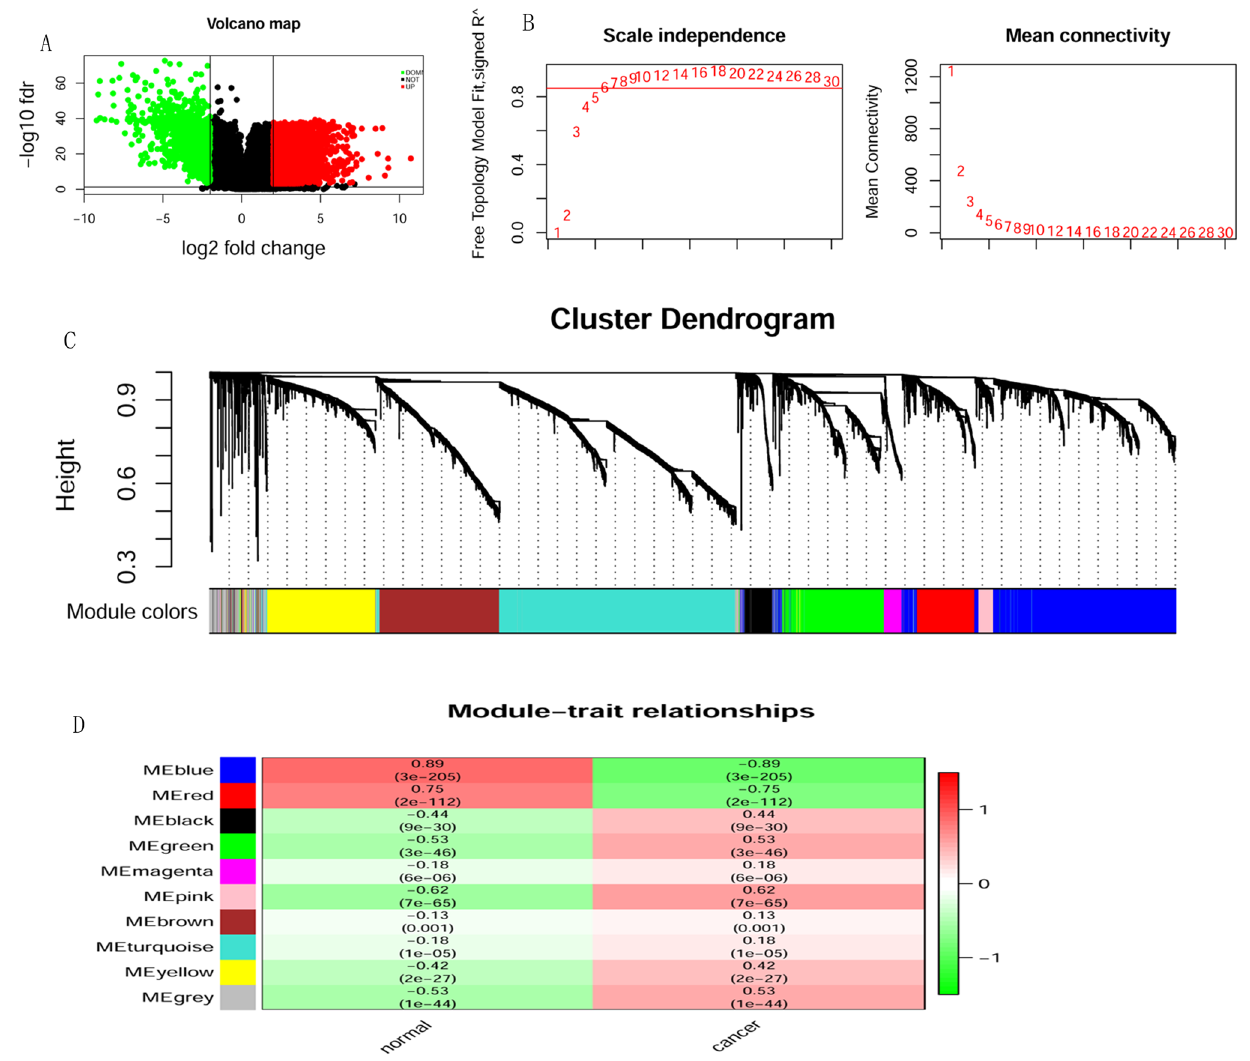
Figure 2. Results of DEGs and WGCNA analysis. ( A ) Volcano. The red part indicates the genes highly expressed in KIRC, and the green part indicates the genes with low expression. ( B ) The soft threshold for filtering WGCNA using the pickSoftThreshold method is 6. ( C ) The clustering algorithm divides the genes into ten different modules, and different colors in the clustering number in the figure represent different modules. (D) Module trait relationships. Green indicates a negative correlation; red indicates a positive correlation. The graph’s blue module (MEblue) has the largest negative correlation with the trait, and the pink module (MEpink) has the largest positive